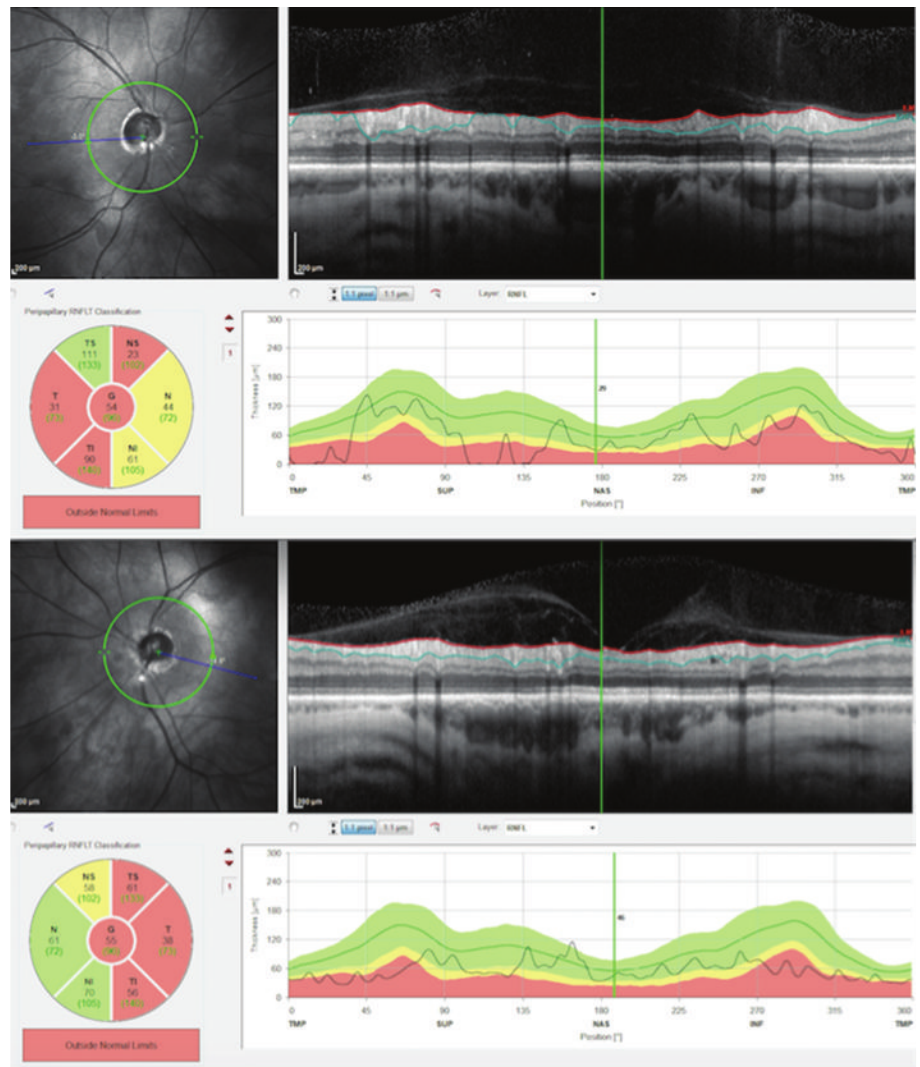
Figure 8: Spectral domain optical coherence tomography of the peripapillary retinal nerve fiber layer in an adult patient with neurofibromatosis type 1 showing reduction of thickness in both